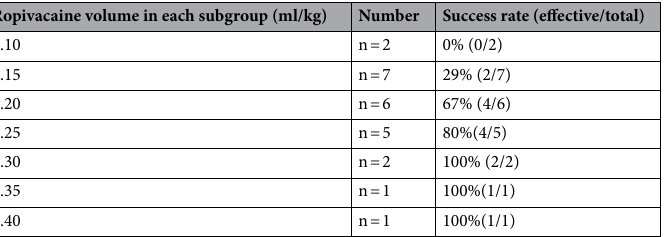
Table 2. The percentages of patients with effective blocks in each subgroup. Data are presented as %